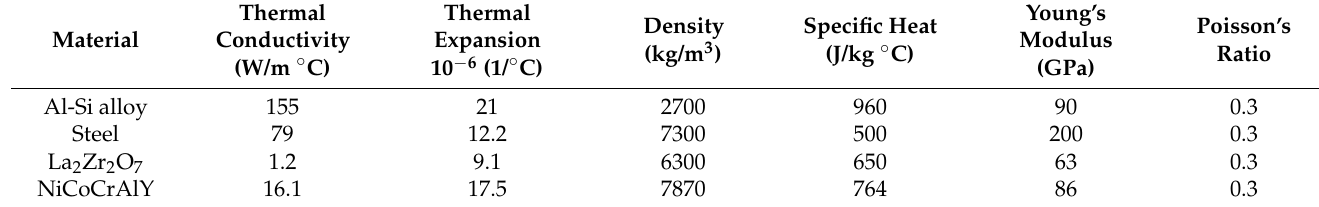
Table 2. The material properties of La 2 Zr 2 O 7 barrier layer, bonding layer and piston substrate [13–16].